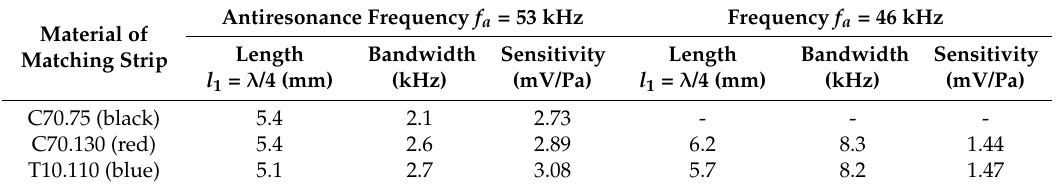
Table 2. In this table, the obtained frequency bandwidths and sensitives are also presented. Table 2. Properties of ultrasonic receivers with matching strips made of different AIREX type